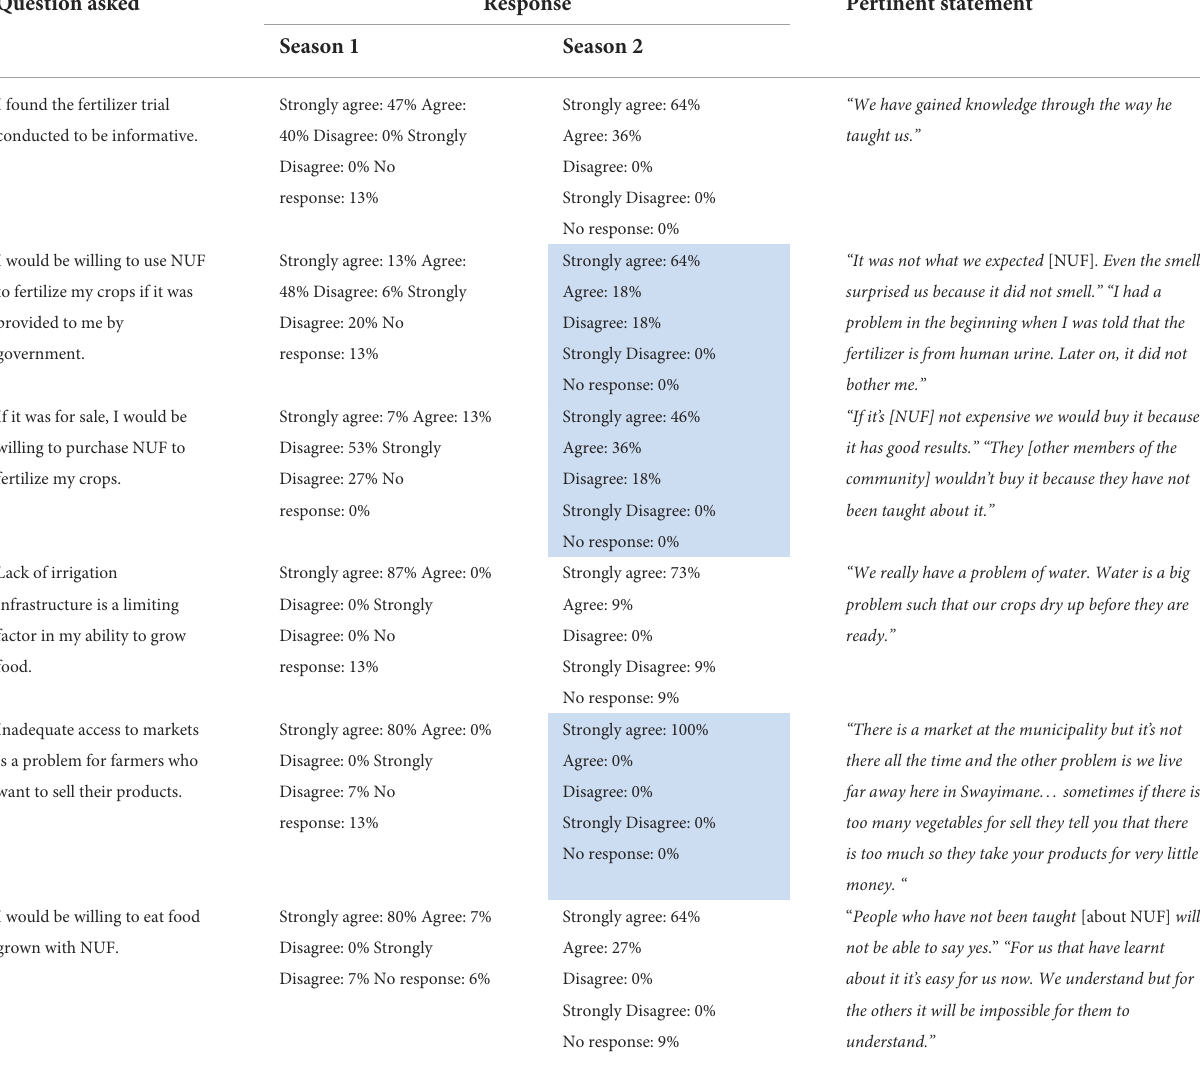
TABLE 4 Results of the individual questionnaire disseminated at the end of seasons 1 and 2 ( n = 15). Question